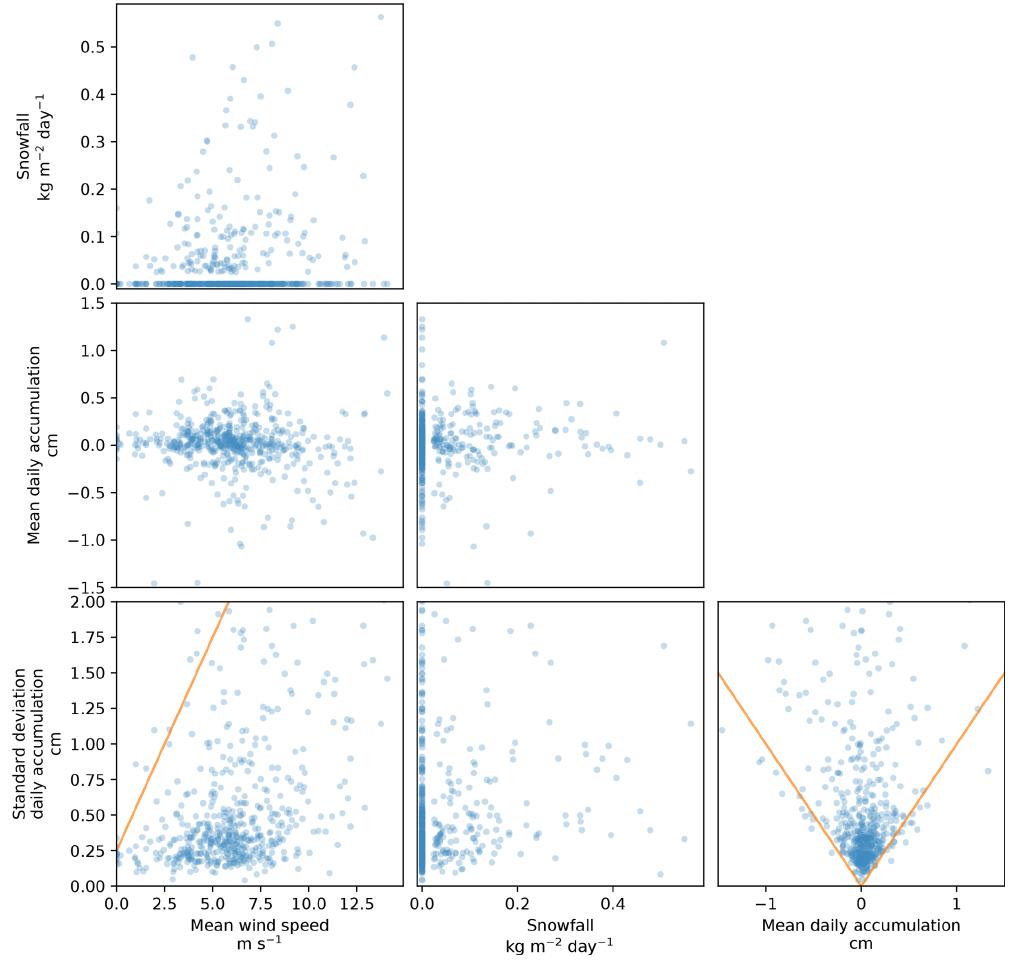
Figure 5. Comparison between mean daily accumulation, standard deviation of daily accumulation, daily snowfall, and mean daily wind speed including data from the 3 years. The orange lines delineate remarkable zones with few data (see Sect.